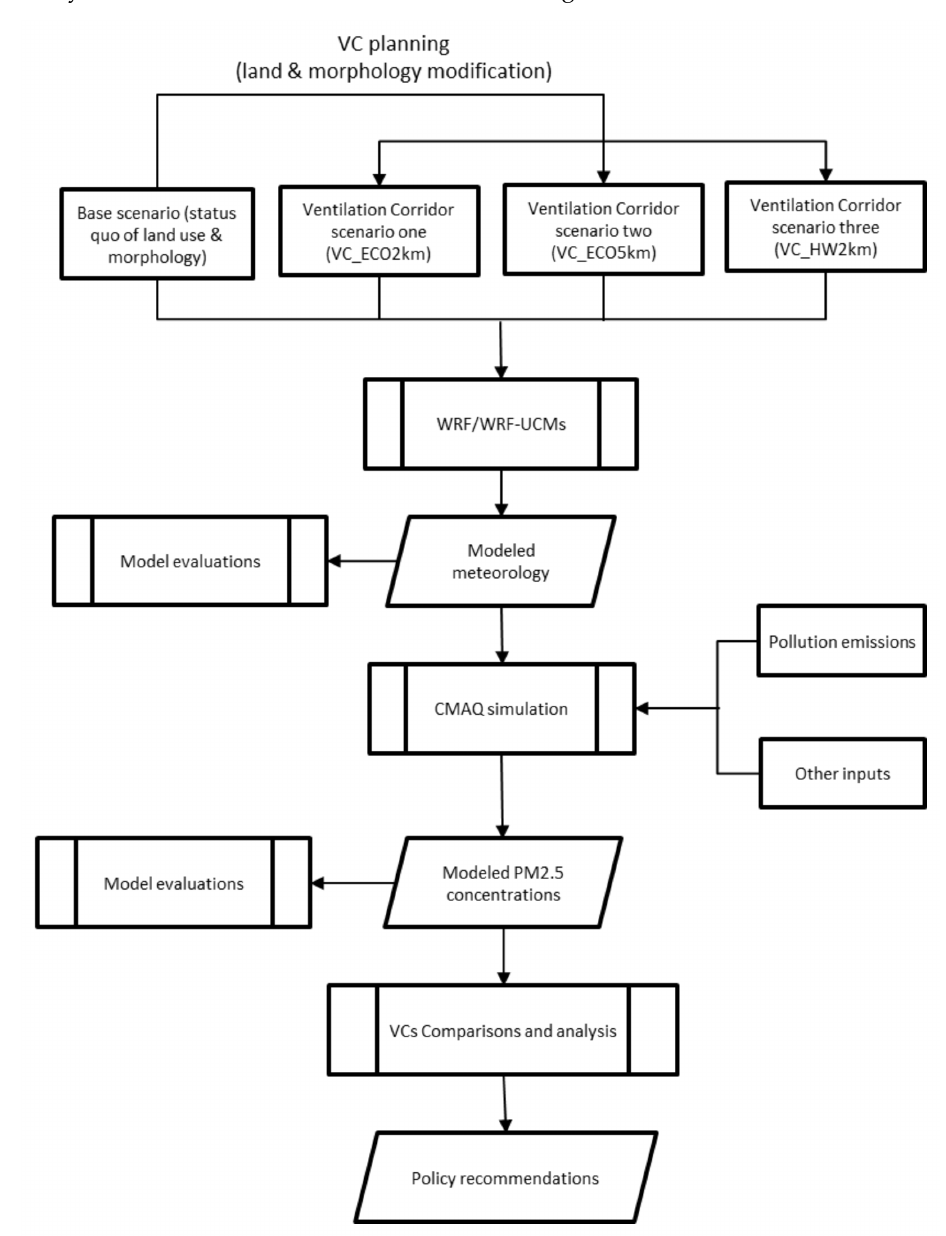
Figure 1. Flow chart of the research on the VCs’ effects on PM2.5 pollution on an urban